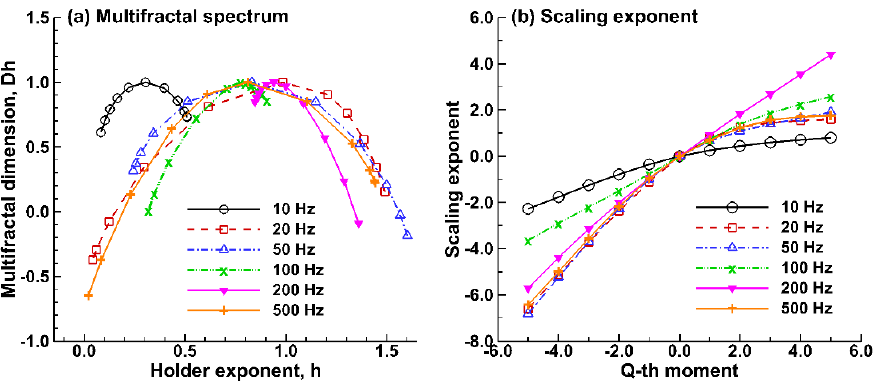
Figure 9. Multifractal analyses of the pressure signals for varying glottal vibration frequencies: ( a ) multifractal spectrum and ( b ) distribution of scaling exponents.